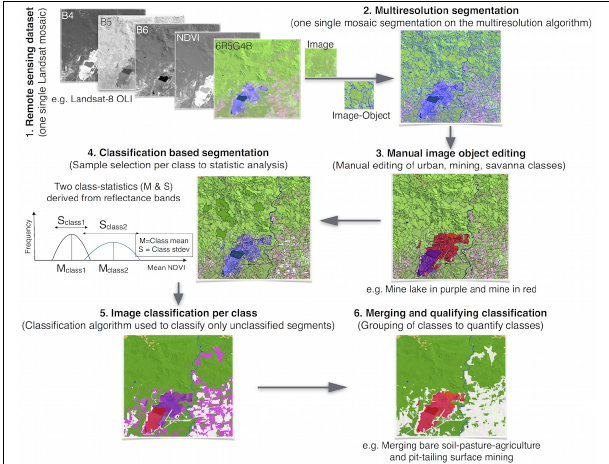
Figure 2. Empiric GEOBIA workflow that illustrates